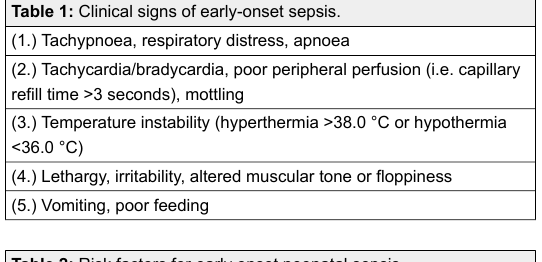
Table 2: Risk factors for early onset neonatal